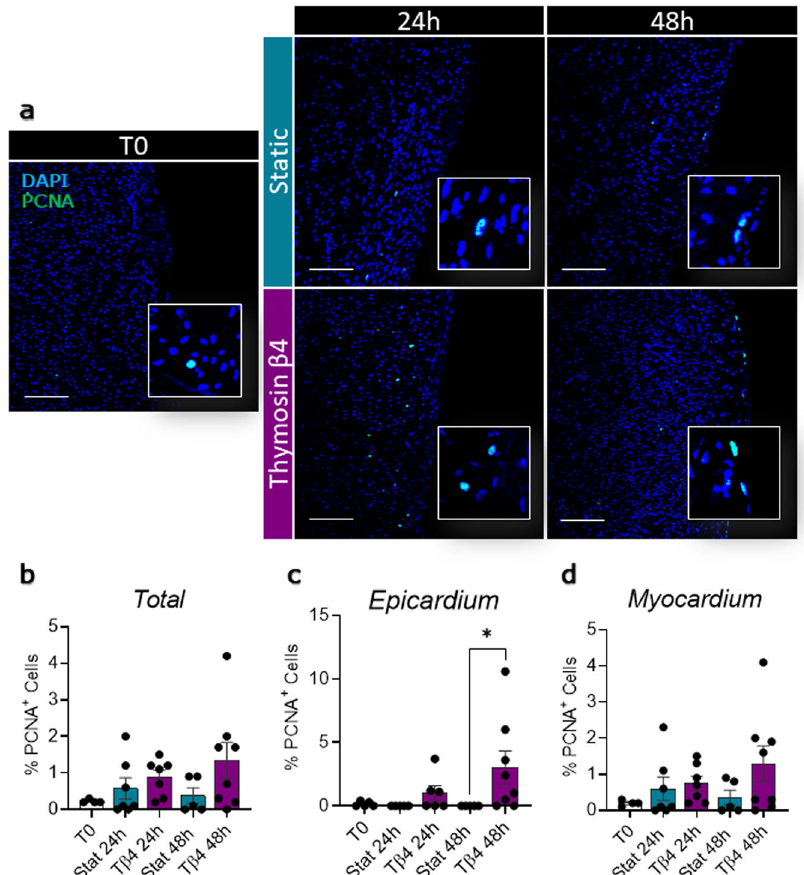
Fig. 9 Percentage of proliferative cells assessed by PCNA staining. Representative images of the PCNA expression in freshly cut slices (T0), and after 24 and 48 h of control static culture (Stat) and thymosin β 4 (T β 4) treatment ( a ). Quanti fi cation of the percentage of proliferative cells normalized on total nuclei, in the whole slice ( b ), in epicardial ( c ), and myocardial area ( d ). N of pigs = 5 – 6, number of slices displayed in the graph. All graphs display data as mean ± SEM. * p ≤ 0.05. Scale bar, 100